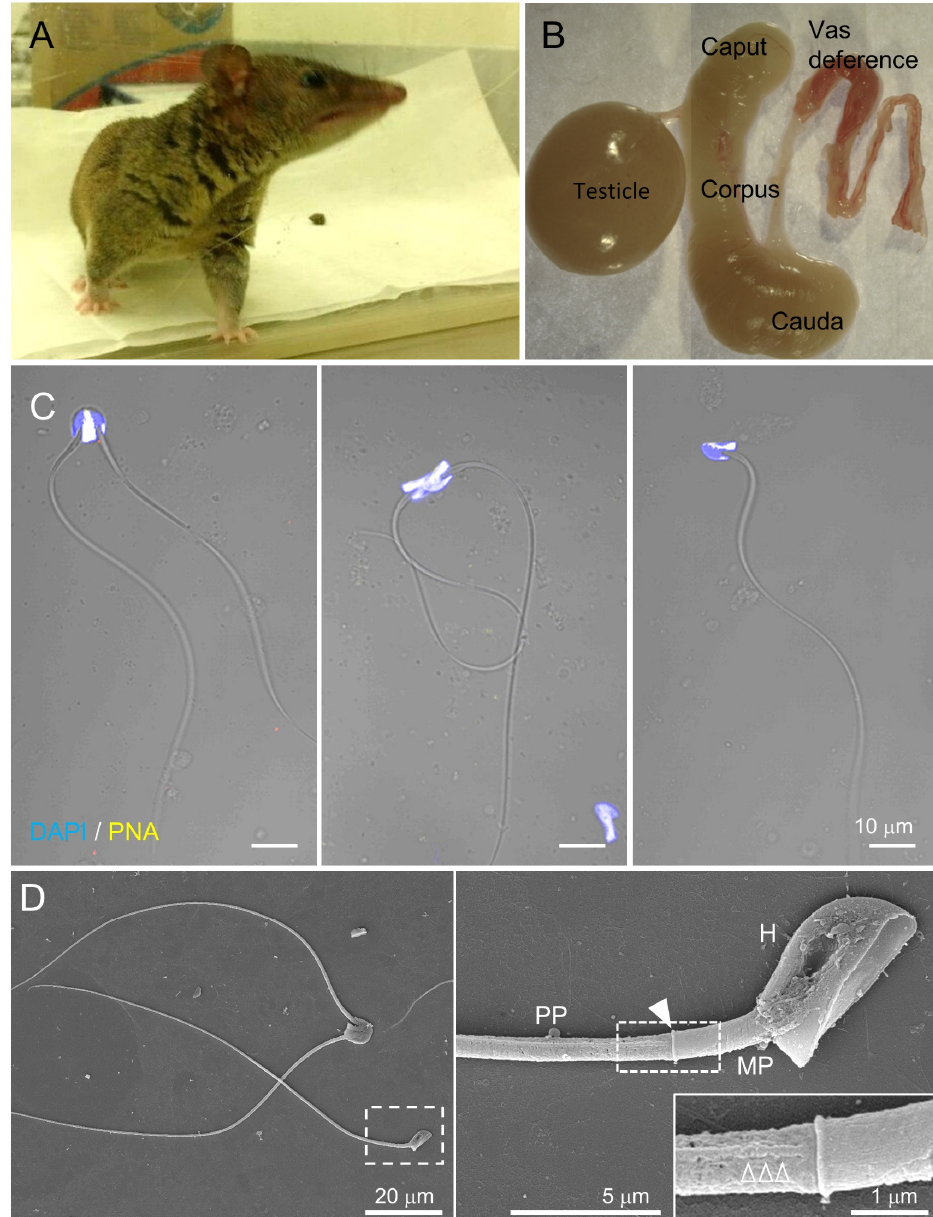
Figure 2. Gray short-tailed opossum sperm share subflagellar compartmentalization conserved in mammalian species. ( A ) An adult male gray short-tailed opossum ( Monodelphis domestica ). ( B ) A half side of the dissected male reproductive tract from an adult opossum. ( C ) Confocal images of the opossum epididymal sperm. Paired (left and middle) or single (right) sperm were observed in which PNA staining depicts the location of the acrosome on the anterior head. Hoechst was used for counterstaining. Fluorescence and corresponding DIC images were merged. ( D ) Scanning electron microscopy images of the opossum sperm. Shown are paired and single sperm (left). Sperm flagella is compartmentalized into midpiece (MP) and principal piece (PP), as shown in the enlarged inset (right). An arrowhead indicates the annulus, a junction between midpiece and principal piece. The magnified region in the right panel shows a longitudinal column (empty arrowheads). H, head. See also Figure